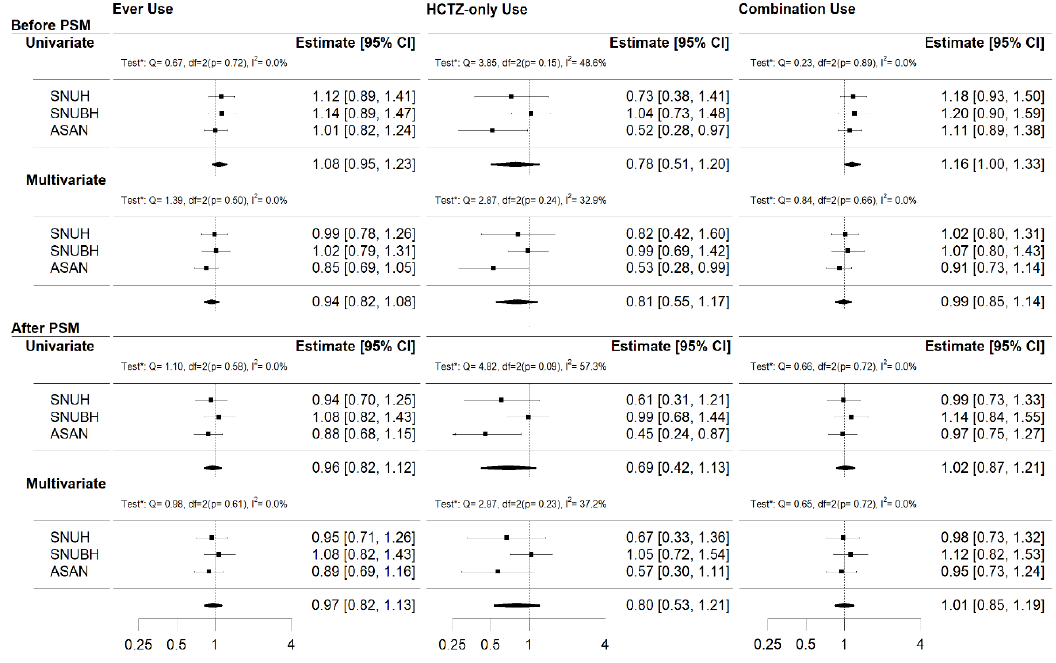
Figure 2. The overall effect of HCTZ use on NMSC in the CDM network for three cases (“Ever use”, “HCTZ-only use”, and “Combination use”). Each analysis was tested for heterogeneity (“Test*” indicates Cochran’s Q and I 2 value tests). In the significant association, the chi-square test for heterogeneity was non-significant and its I 2 value was zero. These suggest that there was little between-study variability in the found association.